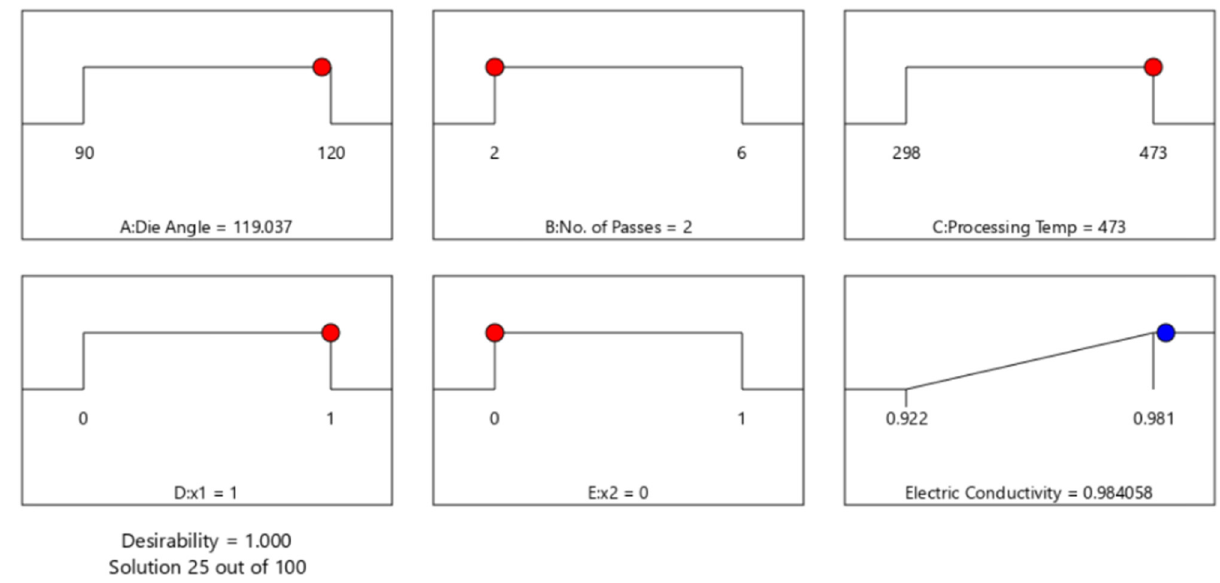
Figure 23: RSM optimization results of E c .